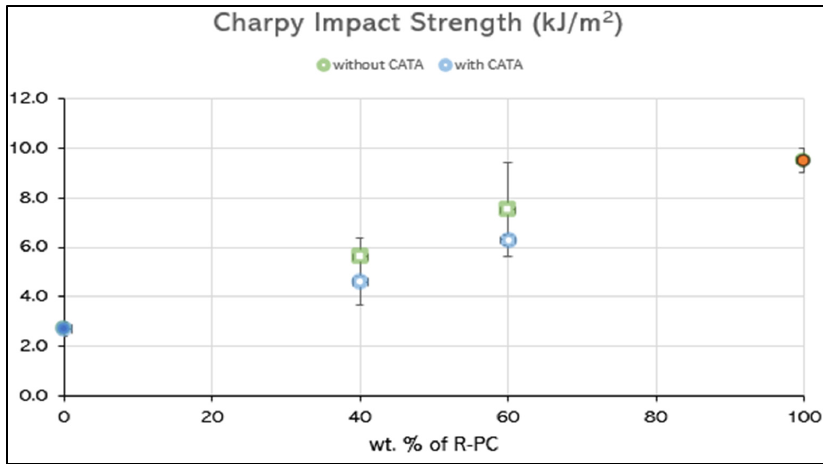
Figure 9 . Trend of the Charpy impact strength over the R-PC quantity in the blend . Figure 9. Trend of the Charpy impact strength over the R-PC quantity in the Table 3. Resumé of the mechanical properties for the blends with the recycled polymers .